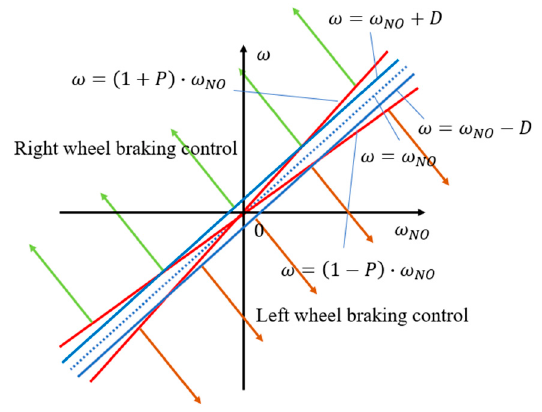
Figure 6. The switching logic of the left and right sides wheel braking control. As shown in Figure 5, the ordinate of the coordinate system is ω and the abscissa is ω NO . The red line is determined by the formula (cid:4698) = 𝑃 , the blue line is determined by the formula |∆𝜔| = 𝐷 , and the blue dotted line distinguishes the area where the left and right wheels brake when there is no brake switching logic. Therefore, unilateral braking needs to be performed in areas where the red line and blue line are unexpected, and the controller does not work in the inner area. Obviously, whether it is switching from the left braking control to the right braking control or from the right braking control to the left braking control, it will pass through an area where the controller does not work.